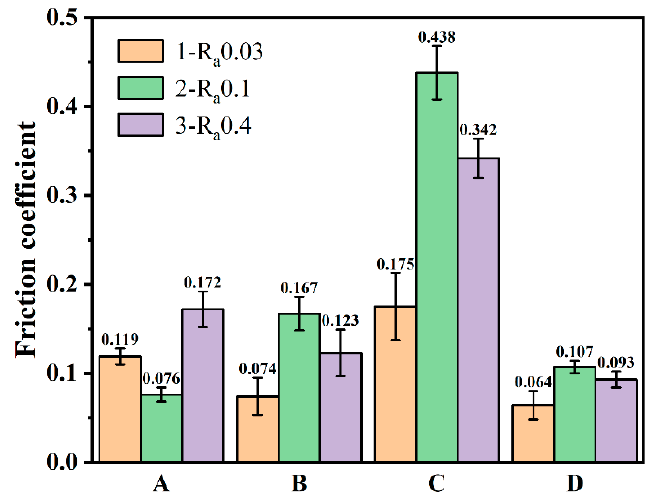
Figure 11. Bar diagram of friction coefficient of diamond films.